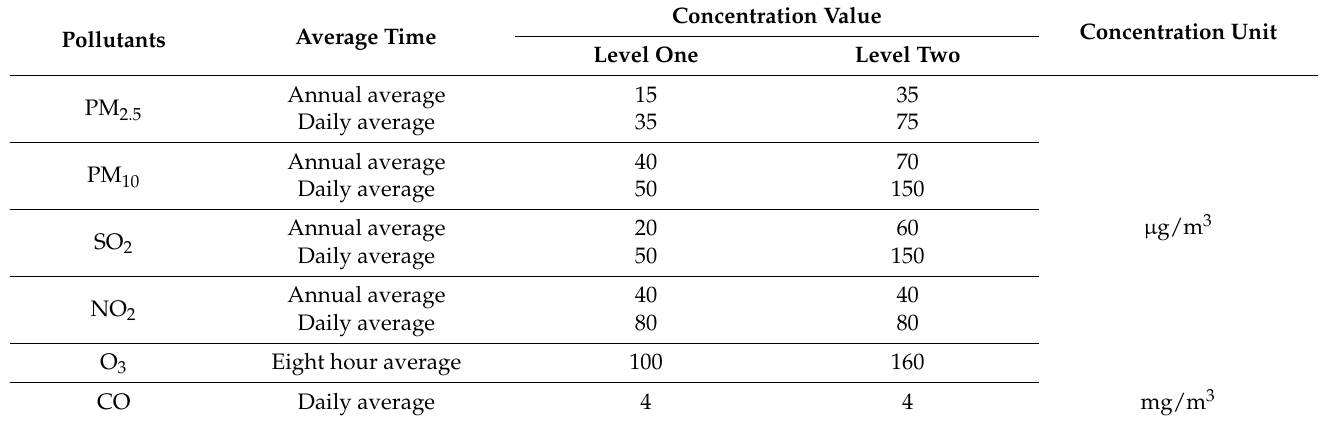
Table 8. Ambient Air Quality Standards (GB 3095-2012) concentration